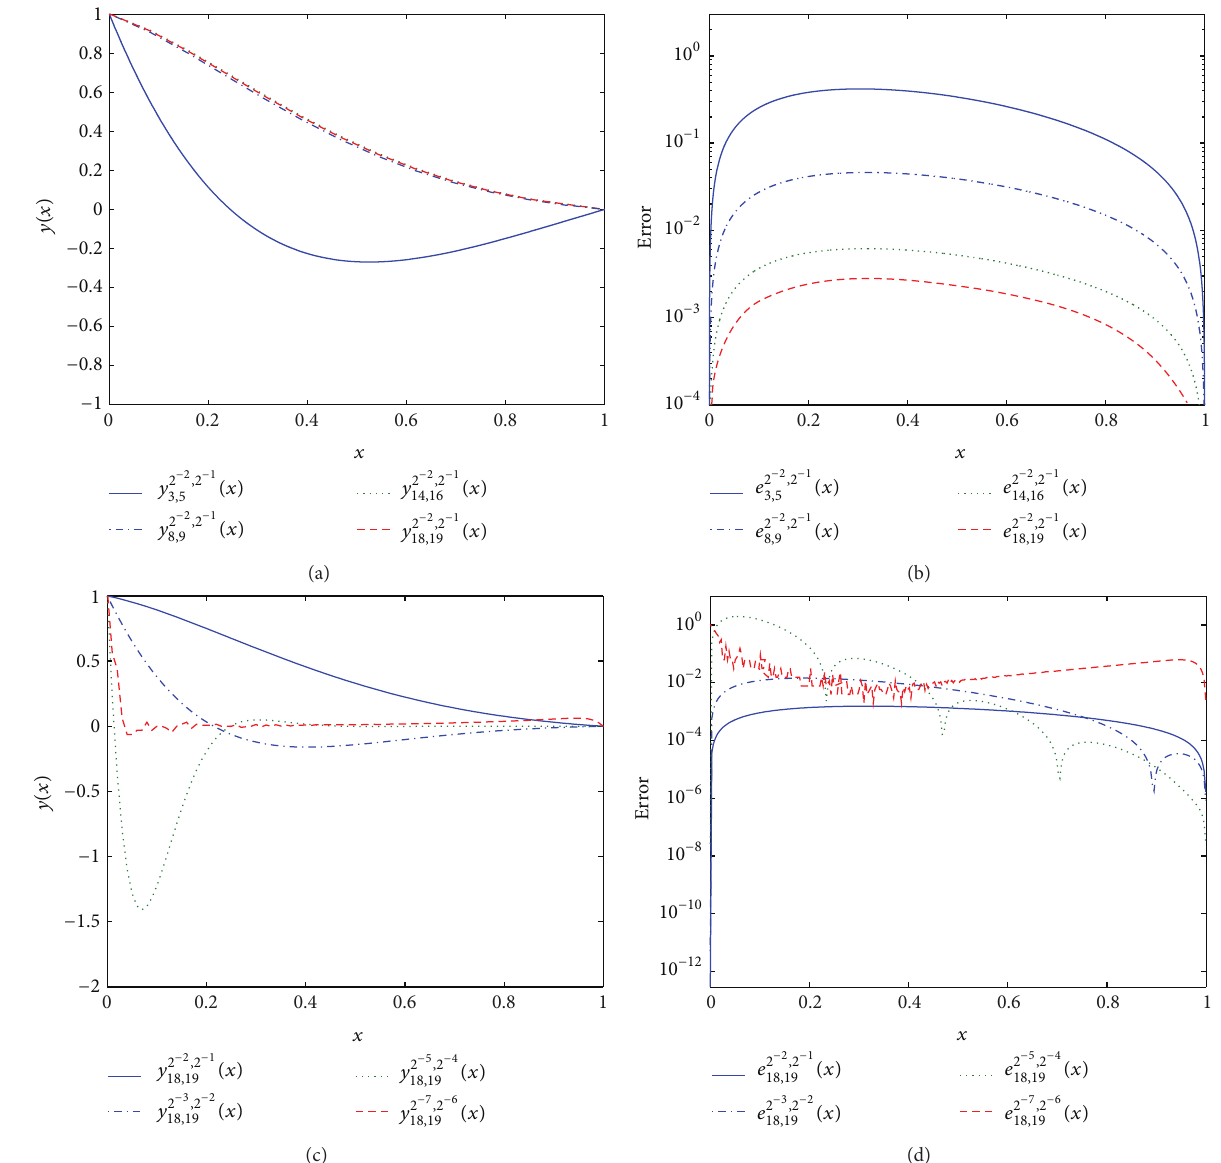
(d) Figure 4: For (45), (a) graph of the approximate solutions for 𝜀 = 2 −2 , 𝛿 = 2𝜀 , and various values of 𝑁 and 𝑀 , (b) comparison of the estimated error functions for 𝜀 = 2 −2 , 𝛿 = 2𝜀 , and various values of 𝑁 and 𝑀 , (c) graph of the approximate solutions for 𝜀 = 2 −2 , 2 −3 , 2 −5 , 2 −7 , 𝛿 = 2𝜀 , 𝑁 = 18 , and 𝑀 = 19 , and (d) graph of the estimated error functions for 𝜀 = 2 −2 , 2 −3 , 2 −5 , and 2 −7 , 𝛿 = 2𝜀 , 𝑁 = 18 , and 𝑀 = 19